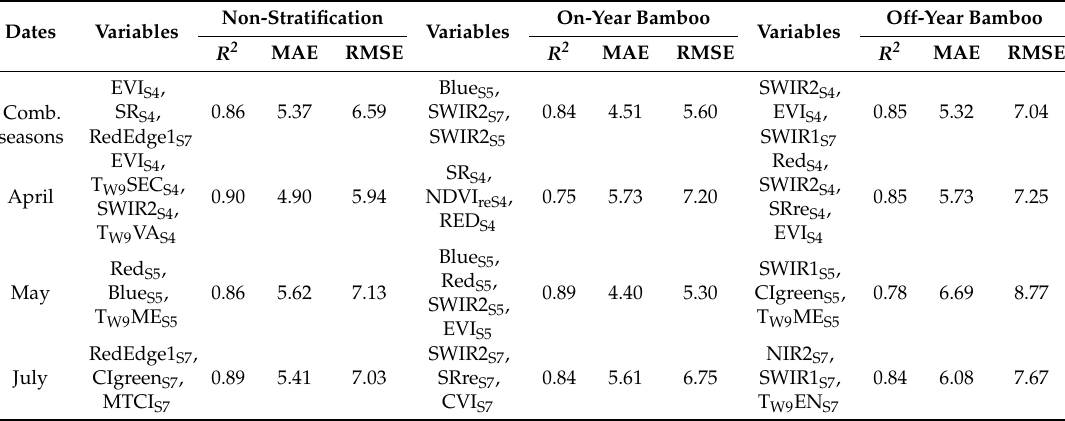
Table 7. A summary of key variables used in random forest.